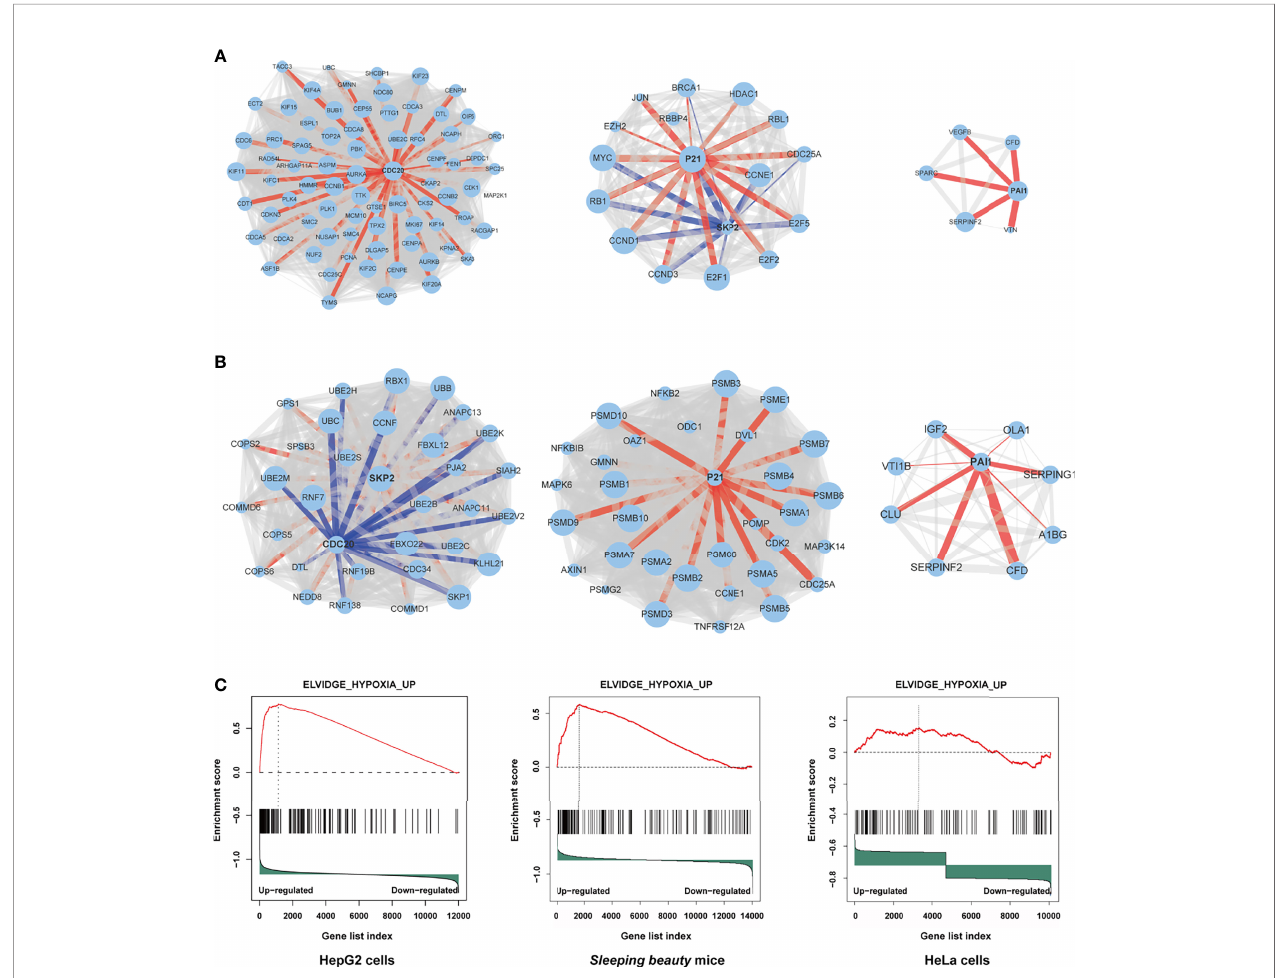
FIGURE 5 | Independent protein-protein interaction (PPI) networks related to the introduction of M3-HBx and Ct-HBx into HepG2 cells by RNA-sequencing. (A) Three independent PPI networks from RNA sequencing data of M3-HBx-expressing HepG2 cells vs those of WT-HBx-expressing HepG2 cells. (B) Three independent PPI networks from RNA sequencing data of Ct-HBx-expressing HepG2 cells vs those of WT-HBx-expressing HepG2 cells. (C) The ELVIDGE_HYPOXIA_UP gene set including PAI1 was signi fi cantly enriched (false discovery rate < 0.05) in the M3-HBx-expressing HepG2 cells, the M3-HBx-expressing HeLa cells, and liver tissues of the M3-HBx-injected SB